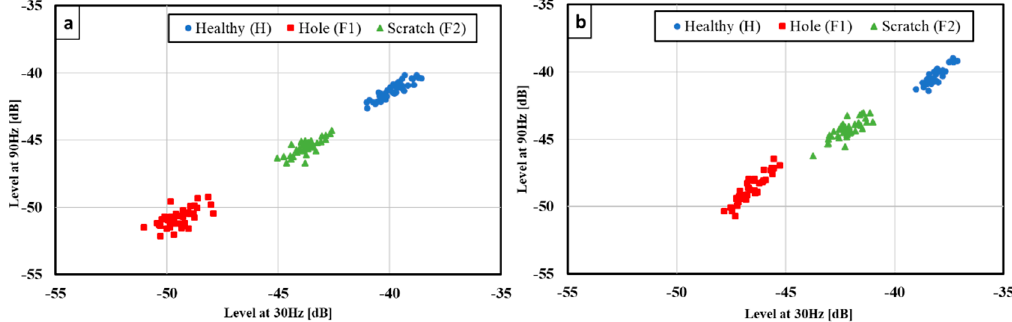
Figure 5. Feature distribution of H-F1-F2 bearing conditions ( a ) considering rotating speed at 1765 min –1 ; ( b ) considering rotating speed at 1770 min –1 .